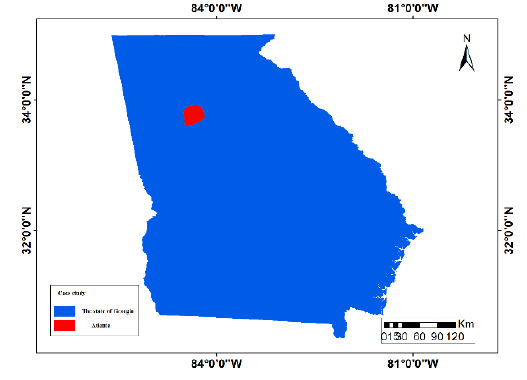
Figure 4. Position of the study